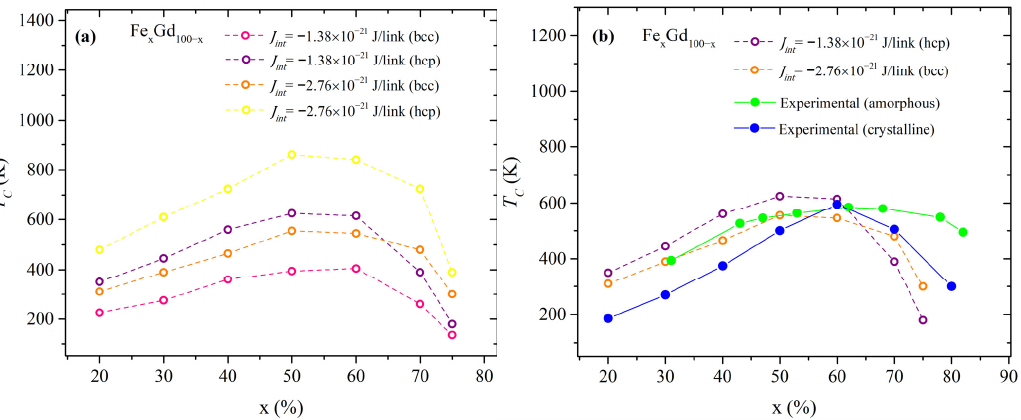
Figure 6. Concentration dependence of the critical temperature of the Fe x Gd 100 − x alloys with bcc and hcp structure for different values of the Fe–Gd exchange energy ( a ) and comparison of theoretical data (open circles) with experimental data (full circles) from Ref. [40] (amorphous structure) and Ref. [3] (crystal structure) ( b ). Table 1. The values of critical temperature obtained from calculations for different Fe x Gd 100 − x alloy compositions and magnetic parameters. The following notation was used: J 1 = J Fe − Gd = − 1.380 × 10 − 21 J/link and J − 2.760 × 10 − 21 J/link. The experimental data 2 = J Fe − Gd =